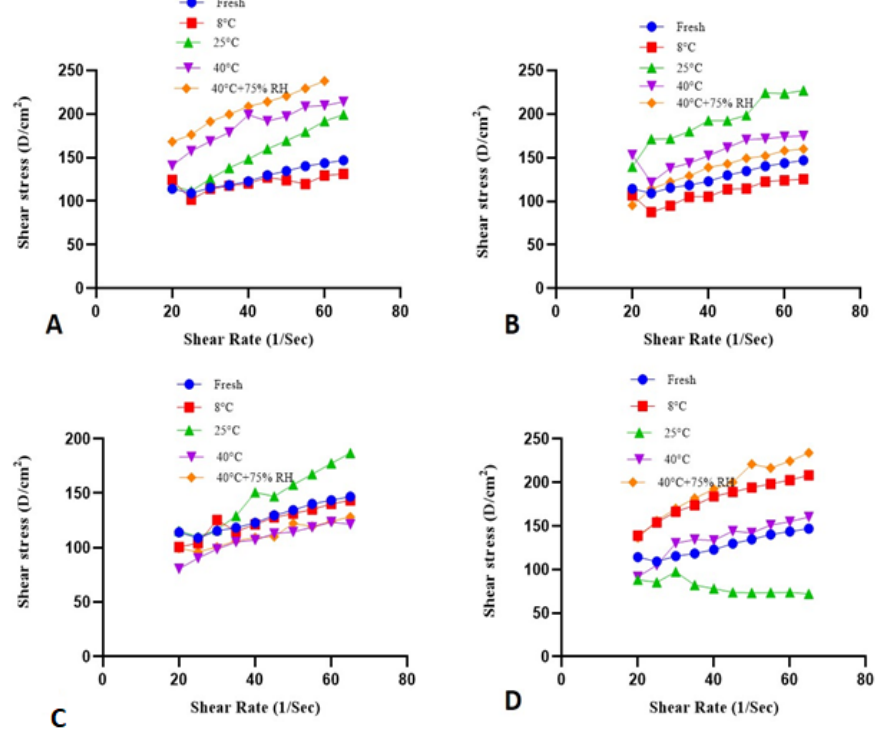
Figure 7. Rheograms of formulation kept at ( A ) (fresh), ( B ) (after 30 days), ( C ) (after 60 days), ( D ) (after 90 days).